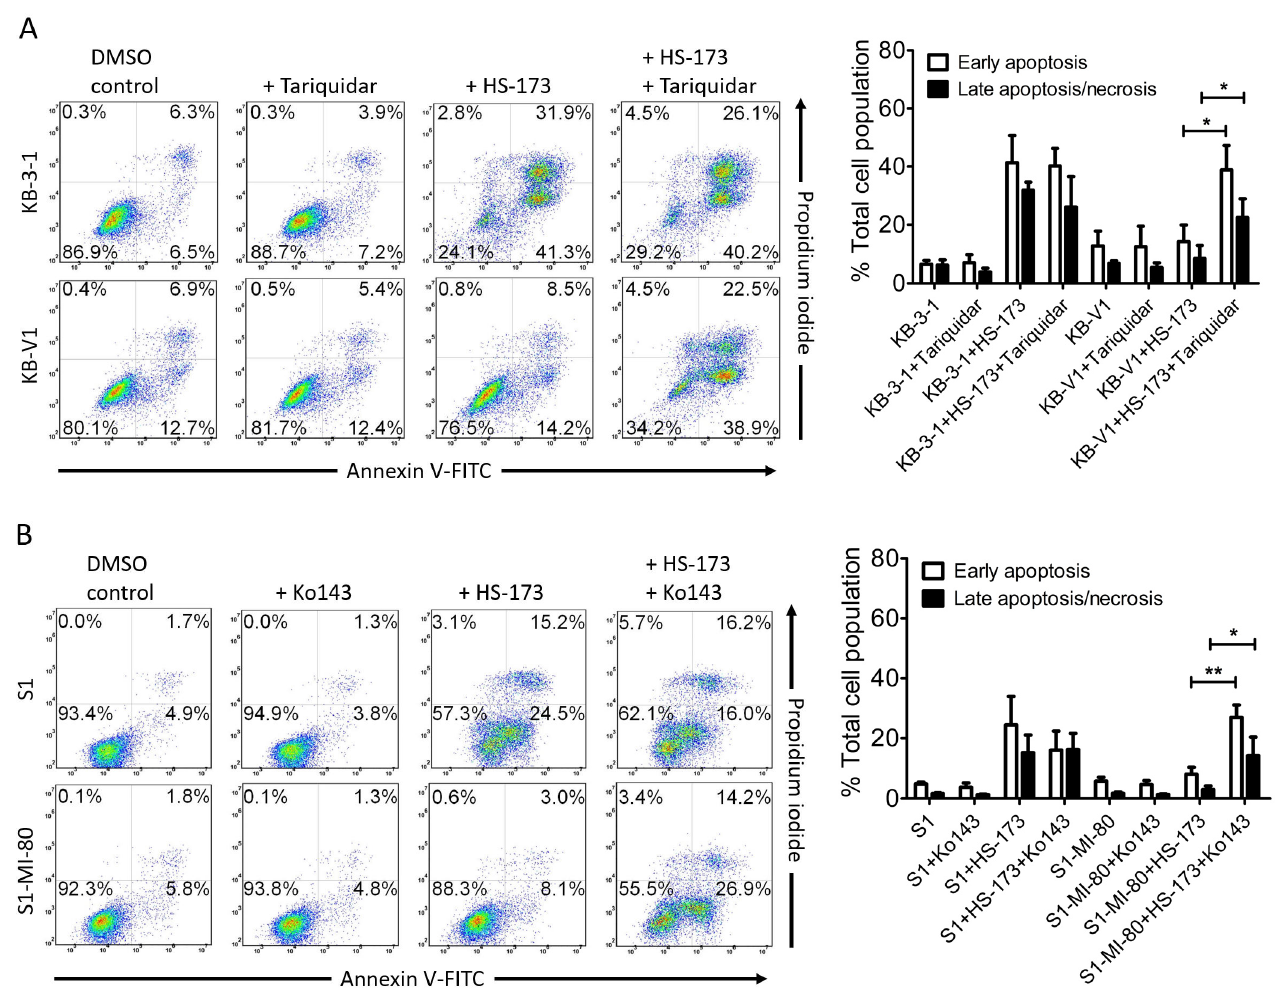
Figure 3. Differential effect of HS-173-induced apoptosis in drug-sensitive cancer cells and multidrug-resistant cancer cells overexpressing ABCB1 or ABCG2. ( A ) KB-3-1 and KB-V1 cells were treated with DMSO (control), 1 µM tariquidar, 2 µM HS-173, or a combination of HS-173 and tariquidar; ( B ) S1 and S1-MI-80 cells were treated with DMSO (control), 1 µM Ko143, 2 µM HS-173, or a combination of HS-173 and Ko143 for 48 h, as described in the Materials and Methods section. The cells were later processed using the Annexin V-FITC and PI staining method and analyzed by means of flow cytometry. Representative dot plots (left panel) and quantified values (right panel) are mean values ± SD calculated from more than three independent experiments. * p < 0.05; ** p < 0.01, versus the same treatment with the addition of tariquidar or Ko143.